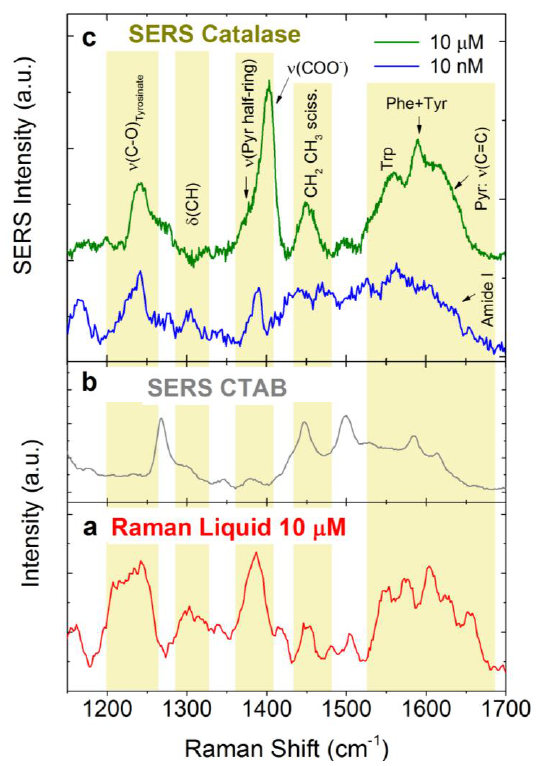
Figure 8. ( a ) Raman spectrum in liquid of Catalase diluted at 10 µM in PB 10 mM (P = 18 mW, T = 240 s, five accumulations); ( b ) SERS spectrum of CTAB (grey line—P = 6.5 mW, T = 1 s, 120 accumulations); and ( c ) SERS spectrum of Catalase acquired with the LIQUISOR methodology at 10 µM (green line, T =1 s P = 3.5 mW, 30 accumulations) and 10 nM (blue line, T =1 s P = 6.5 mW, 30 accumulations). Yellow boxes highlight the vibrational modes due to the protein.